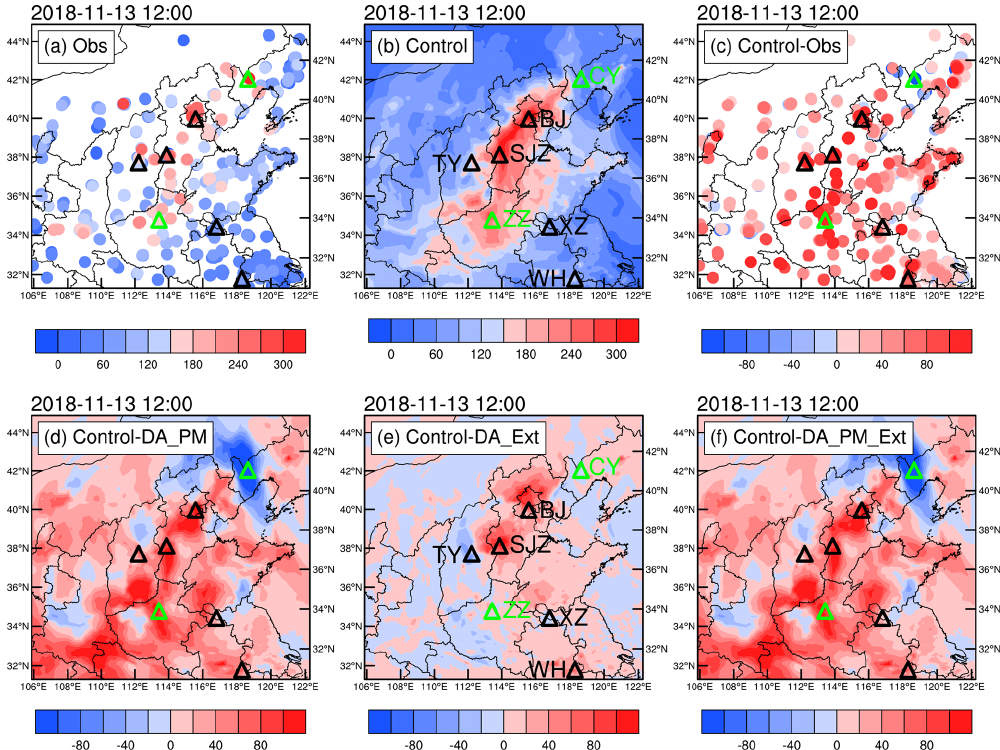
Figure 7. Surface PM 2 . 5 MC measurements (a) , surface PM 2 . 5 MCs in the initial field of control experiment (b) and its bias (c) , the inverse DA increments of PM 2 . 5 MC of DA experiments, that is, the PM 2 . 5 MCs obtained from the control experiment minus that from the DA experiments (d–f) at 12:00UTC on 13 November 2018 (black triangles signify the locations of the lidar stations, and green triangles mark the locations of the two cities without lidar) (CY: Chaoyang; BJ: Beijing; SJZ: Shijiazhuang; TY: Taiyuan; ZZ: Zhengzhou; XZ: Xuzhou; WH: Wuhu).